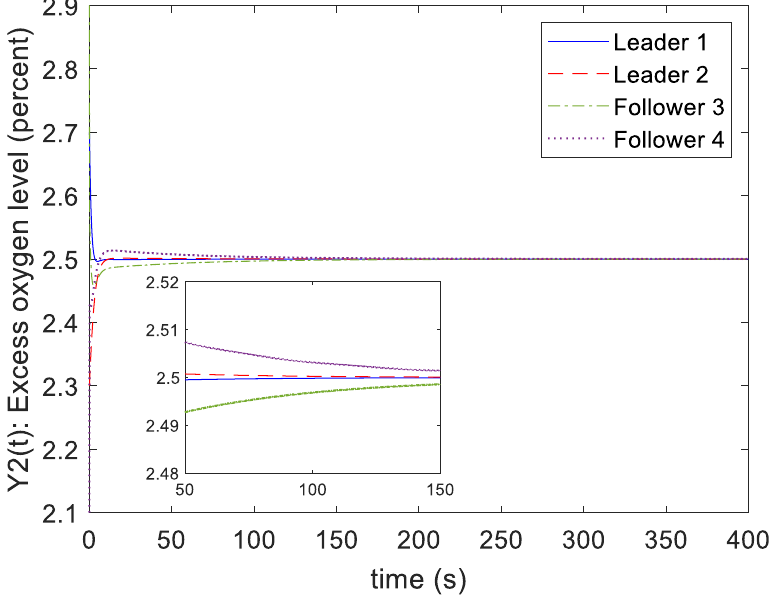
  Y t with type-1 fuzzy control. 1